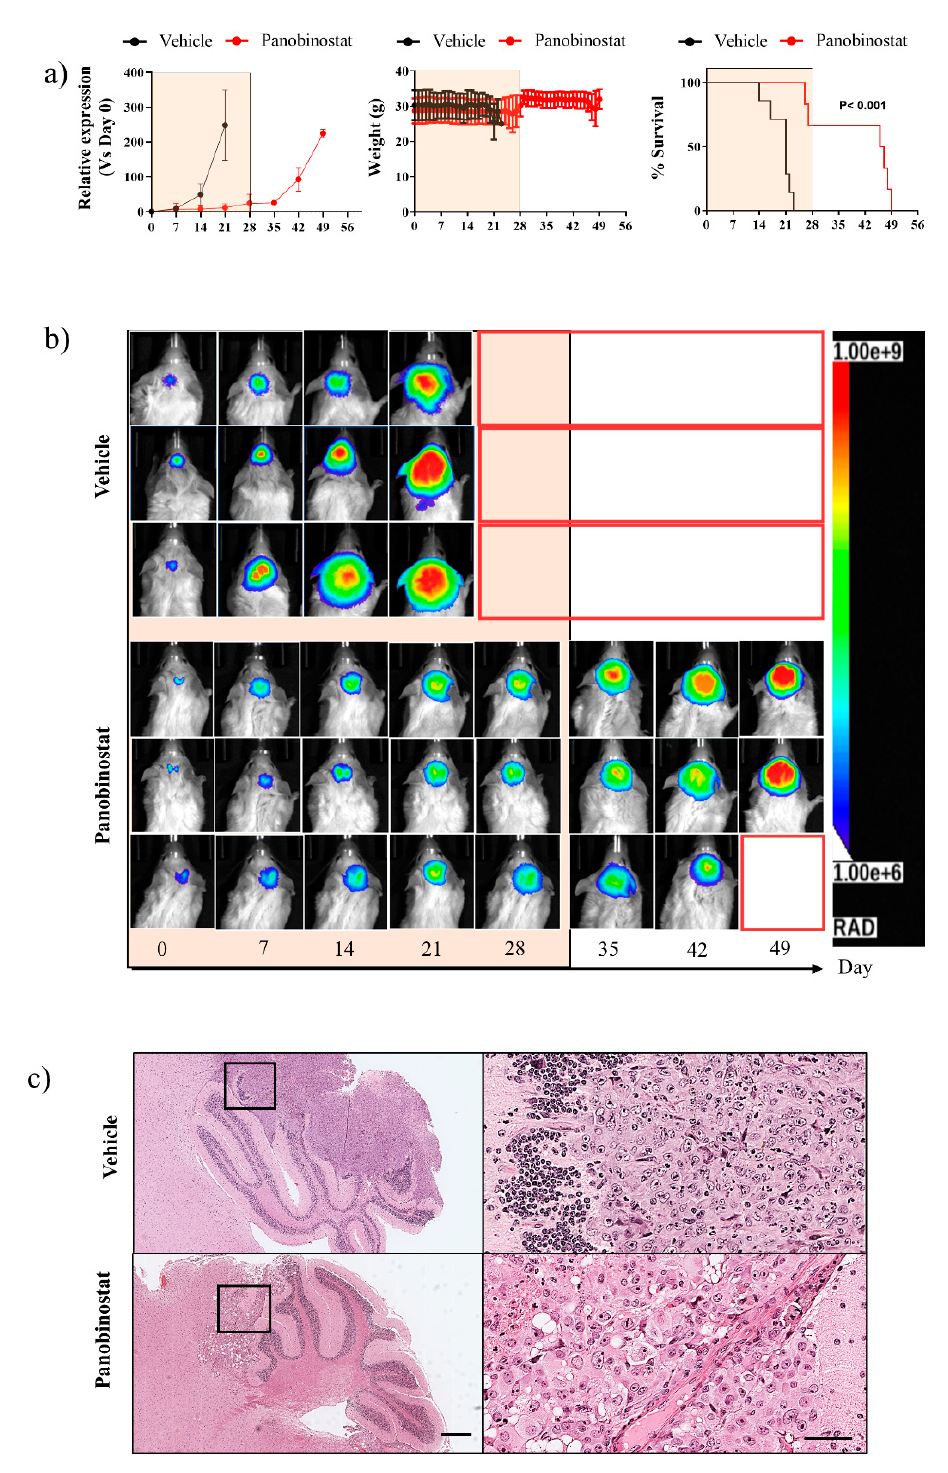
Figure 5. Orthotopic ATRT xenograft model treated with vehicle control or 5 mg/kg panobinostat daily for 28 days. ( a ) Relative bioluminescence intensity of engrafted BT12 Luc-GFP tumours, mouse body weight and the survival proportion of mice ( n = 7; mean ± SEM, p < 0.001). Orange box represents the treatment period. ( b ) Representative bioluminescence images of NSG mice engrafted with BT12 Luc-GFP and treated with vehicle control or 5 mg/kg panobinostat daily for 28 days. Orange box on X -axis represents the treatment period. Treatment withdrawal occurred on Day 28. ( c ) Representative H&E image of brains harvested from mice following treatment with vehicle control or 5 mg/kg panobi- nostat daily for 28 days. Scale bar for left image = 500 µ m; right image = 200 µ